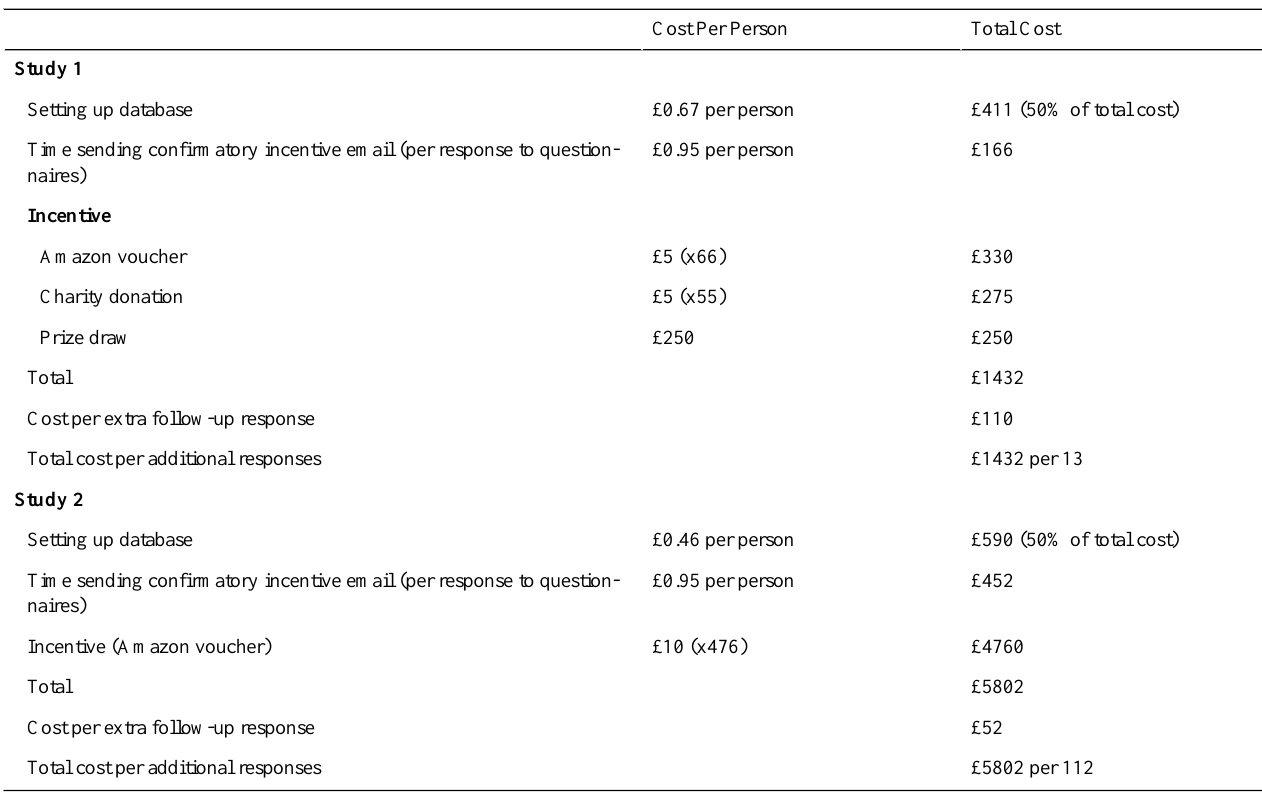
Table 3. Costs associated with offering incentives in study 1 and study